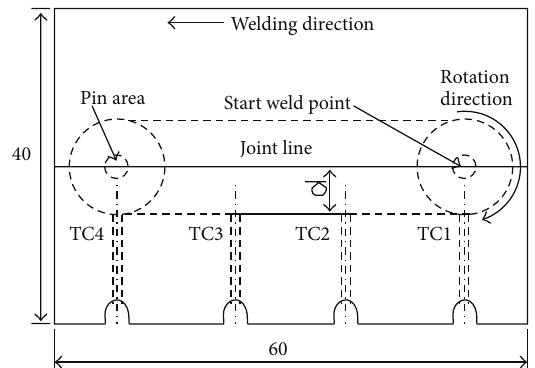
Figure 2: Workpiece dimensions and the thermocouple places in the FSW joints [27].